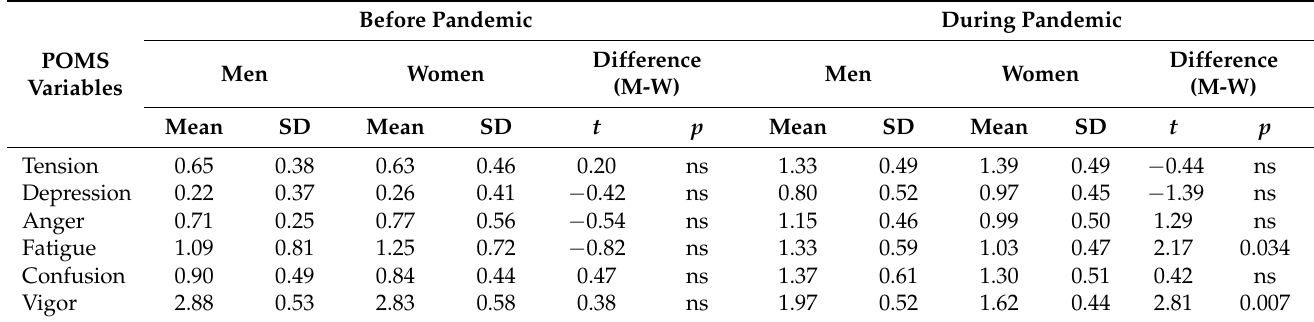
Table 3. Sexual dimorphism of POMS parameters before and during the COVID-19 pandemic.